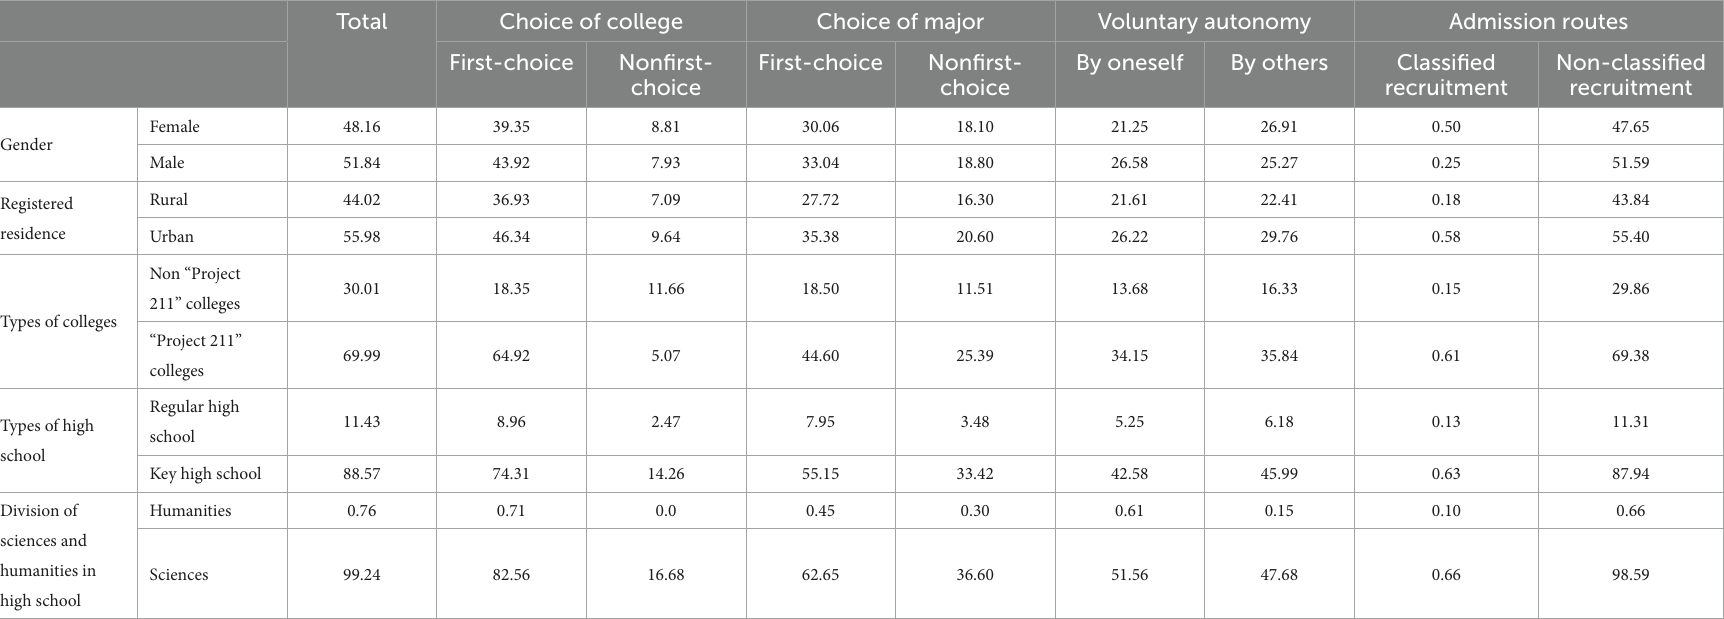
TABLE 2 Basic descriptive statistics